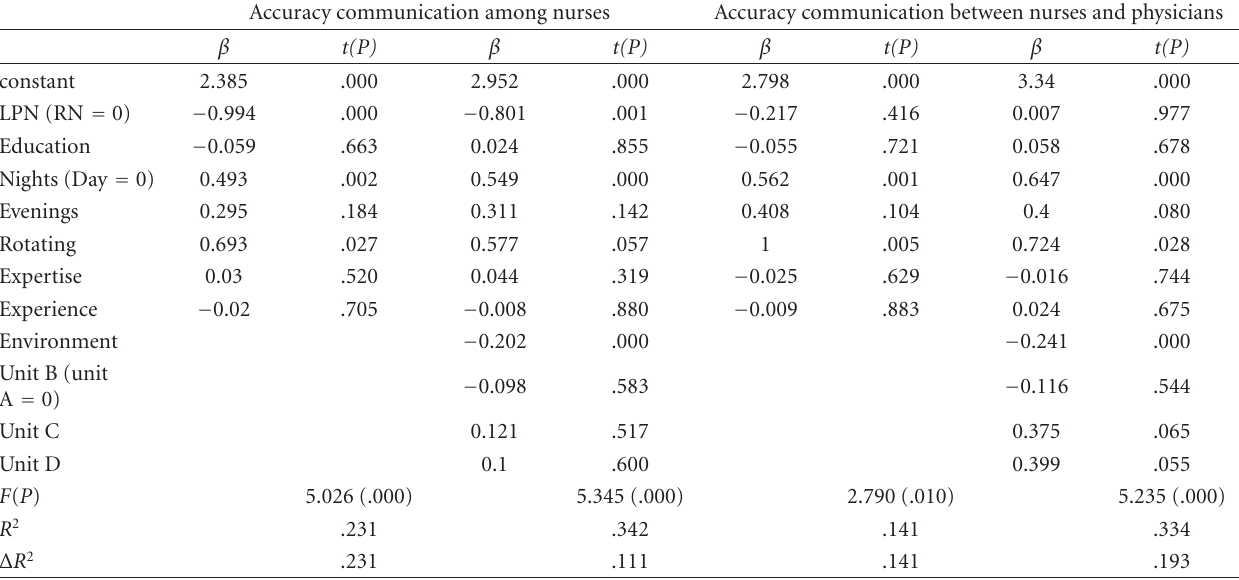
Table 4: Hierarchical multiple regression analysis predicting accuracy of communication ( n =